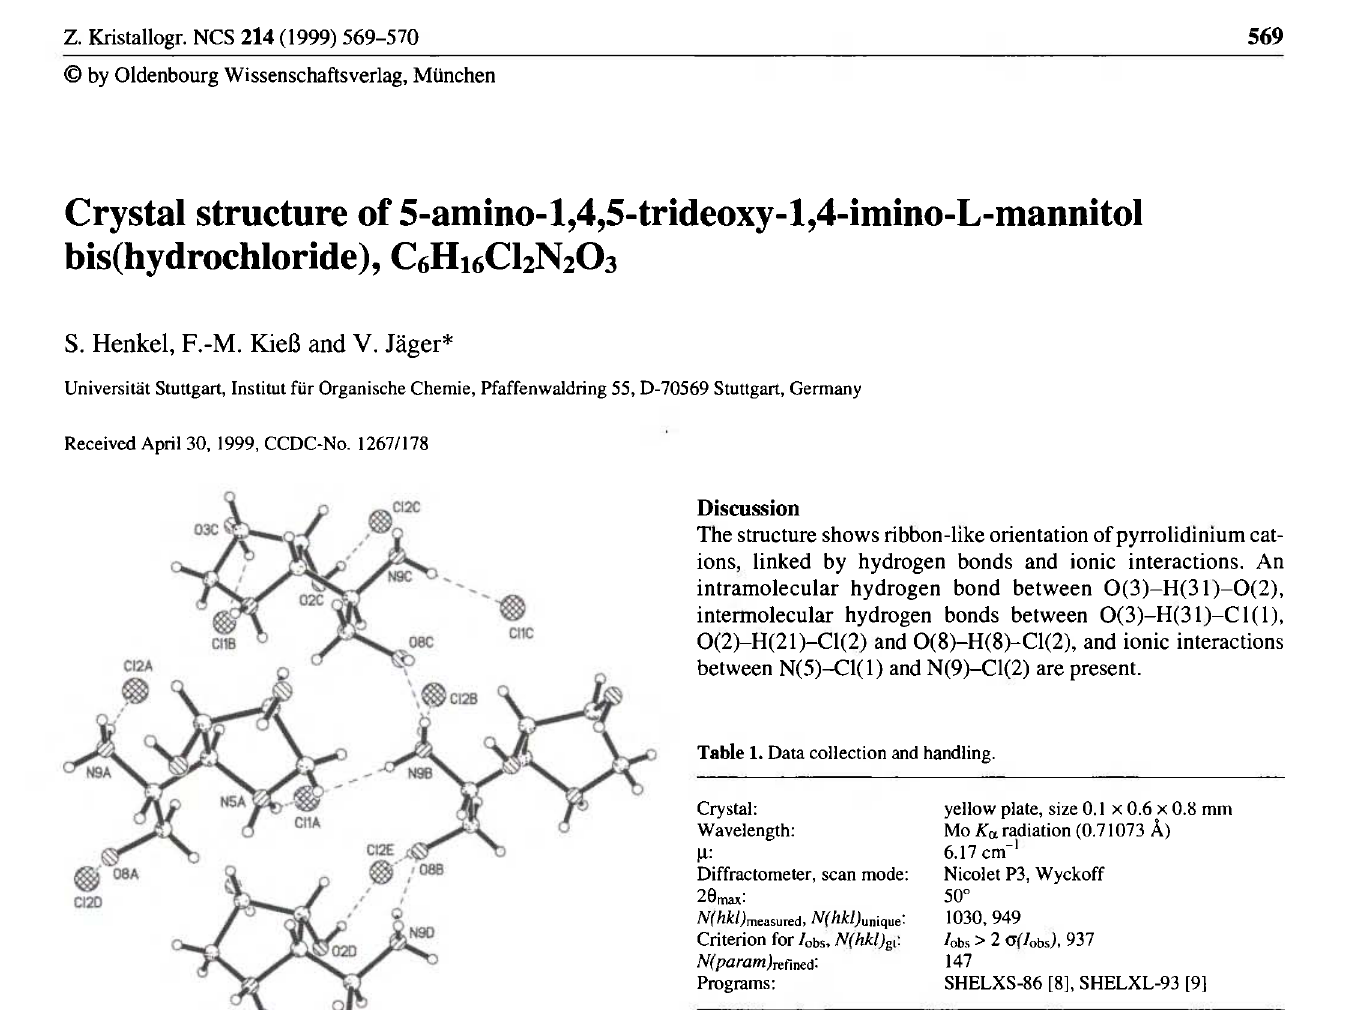
Table 2. Atomic coordinates and displacement parameters (in A 2